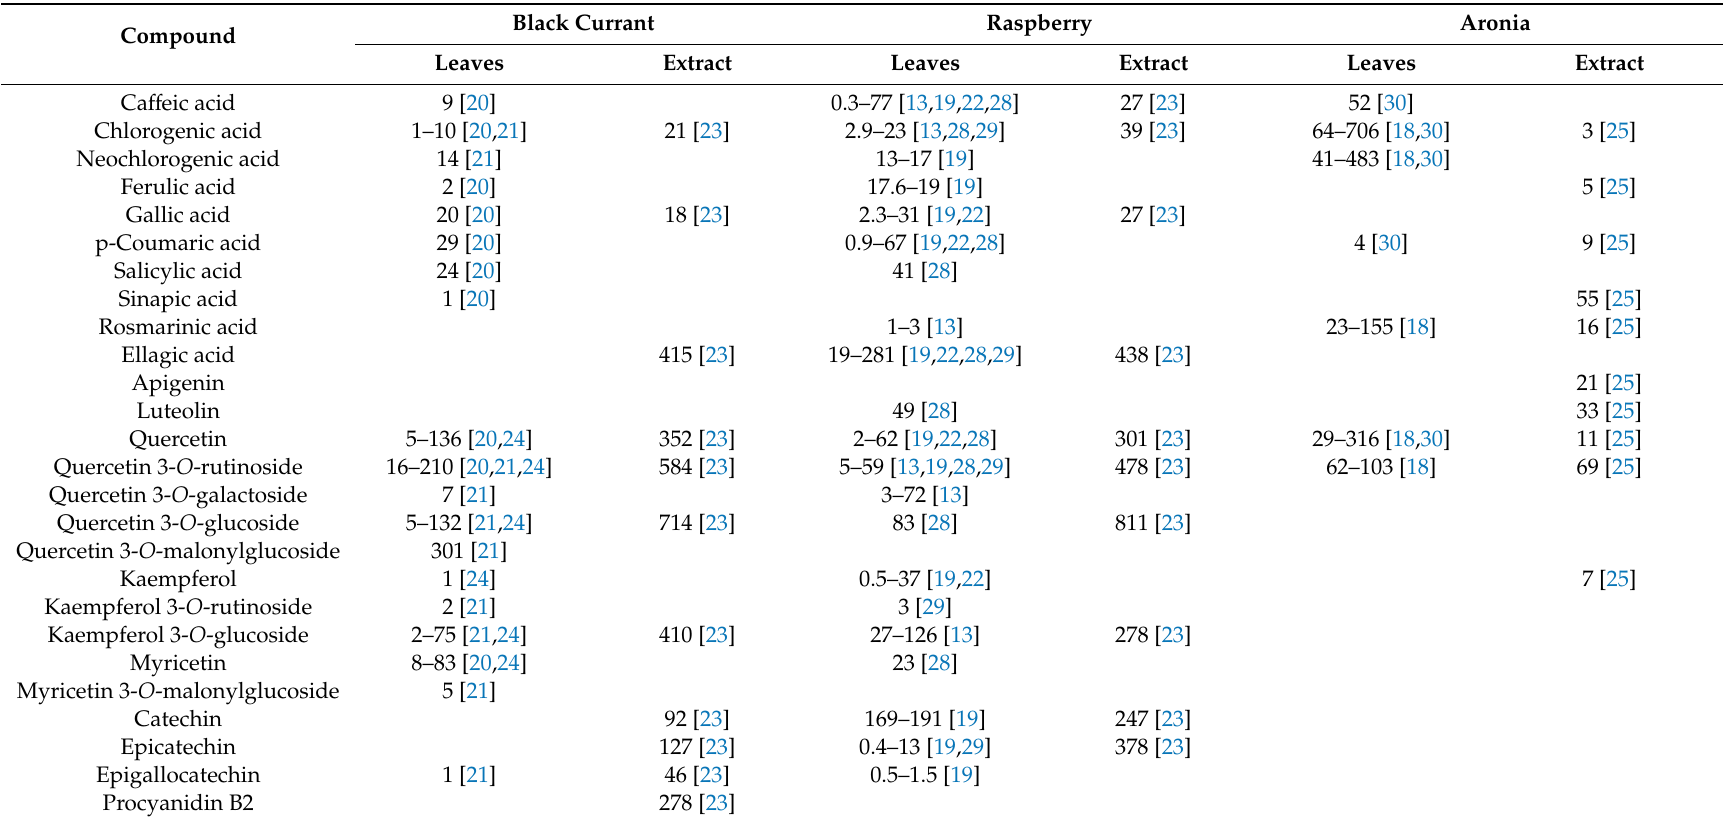
Table 1. Distribution of phenolic compounds in the leaves of black currant, raspberry, and aronia (mg / 100 g dry mass (DM)). Black Compound